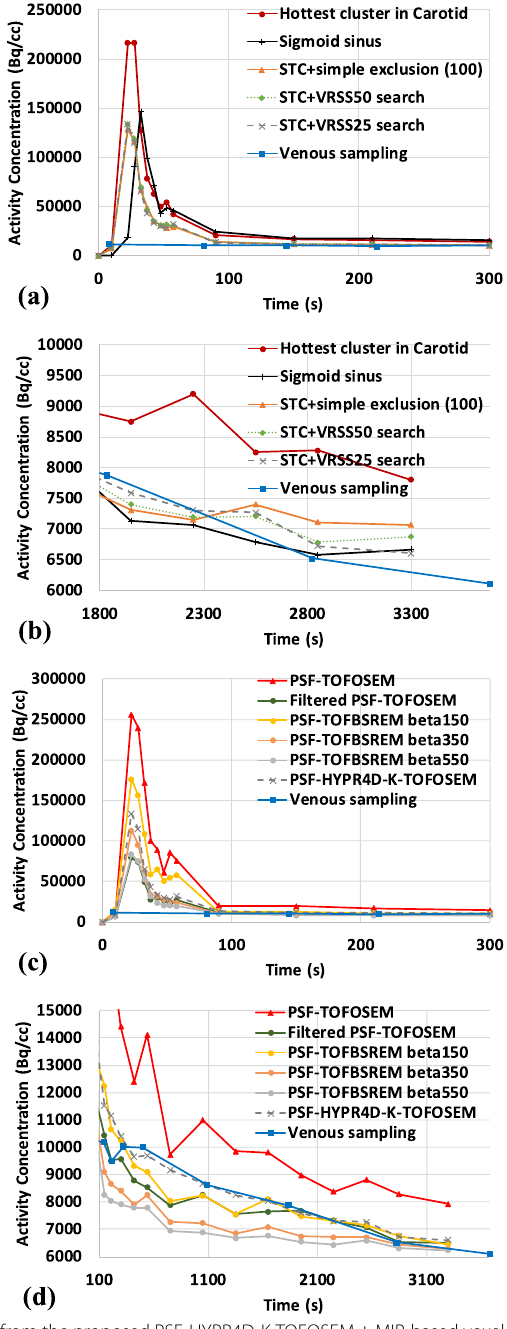
Fig. 7 TACs extracted from the proposed PSF‑HYPR4D‑K‑TOFOSEM sampling for a the first 5 min of the scan, b the last 30 min of the scan, c the first 5 min using STC with various reconstructions, and d after the IDIF peak to highlight the difference between curves from various